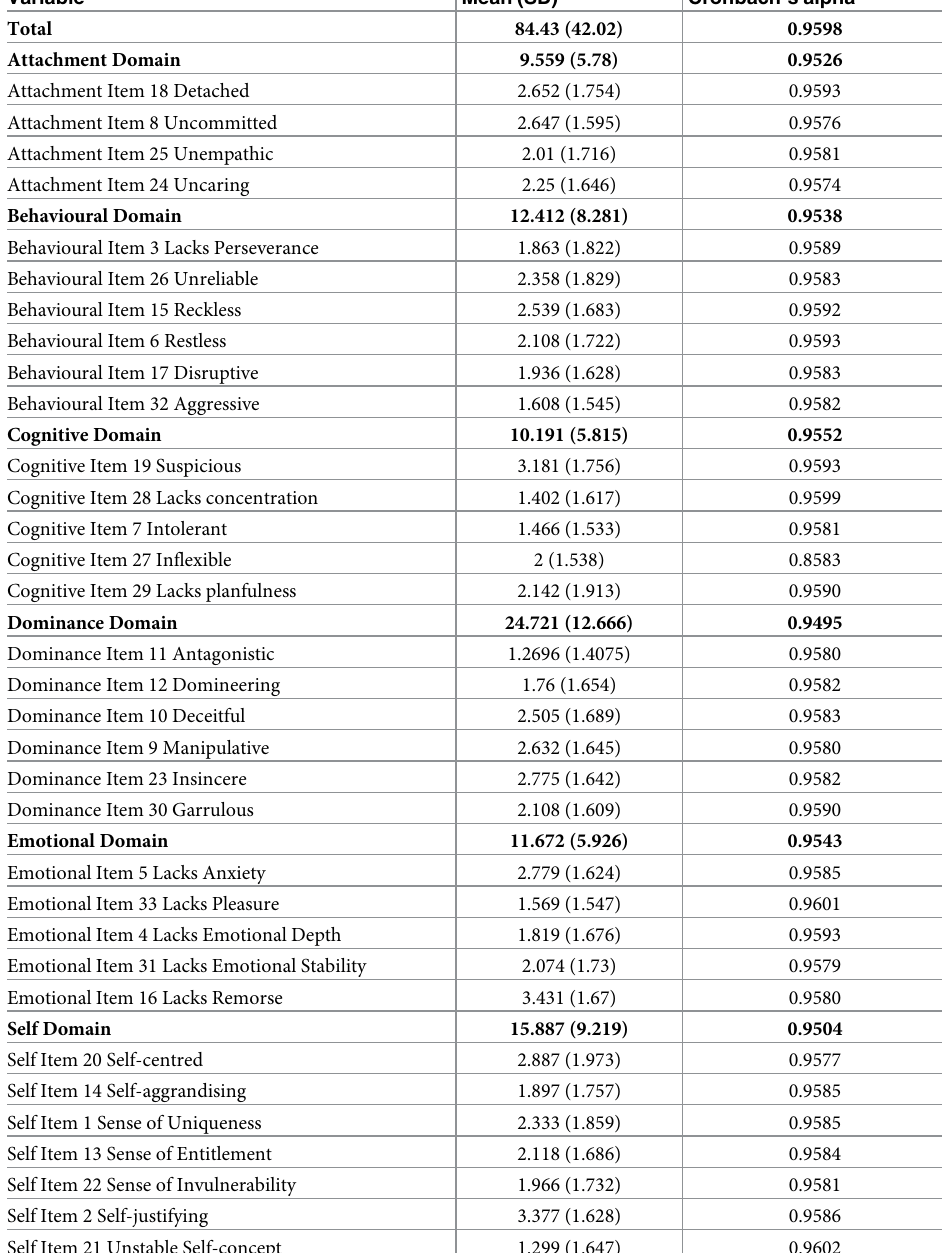
Table 2. Distribution of CAPP total, domains and items. Cronbach’s alpha calculated without the specified